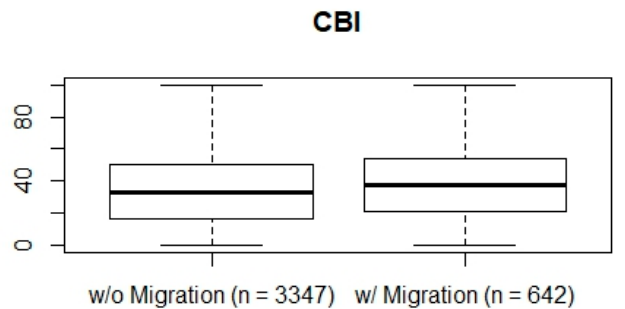
Figure 1. Boxplot of the Copenhagen Burnout Inventory (CBI) values of employees without ( n = 3347) vs. with a migration background ( n = 642).